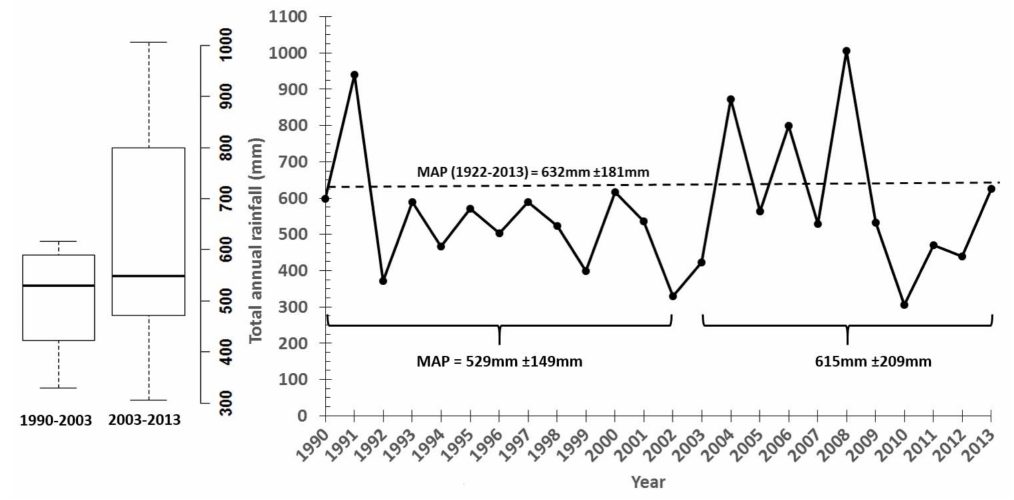
Figure 9. Total annual rainfall (mm) for the study period with long term (1922–2013) mean annual precipitation (MAP) and MAP for each time step with standard deviations shown, along with boxplots of total annual rainfall for the different time